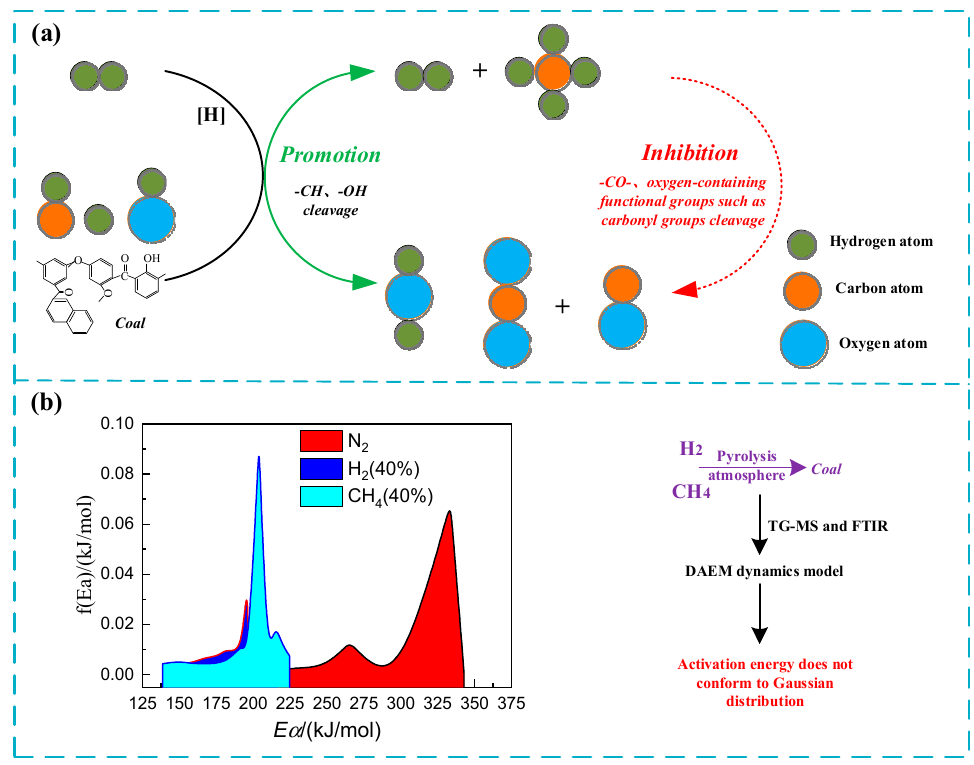
Figure 9. Schematic diagram of the reaction process: ( a ) The process of H 2 and coal pyrolysis and; ( b ) The activation energy distribution under the DAEM model.